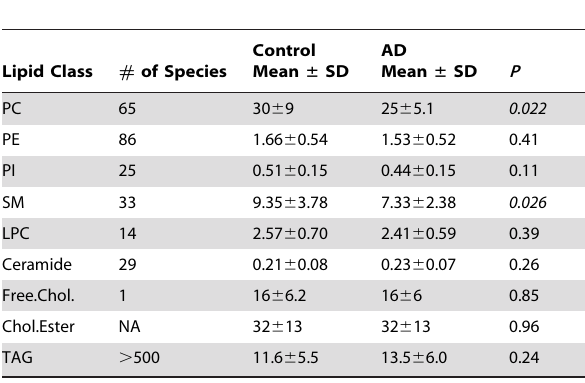
Table 2. Lipid classes, species and their mass levels in Alzheimer and control subjects a .